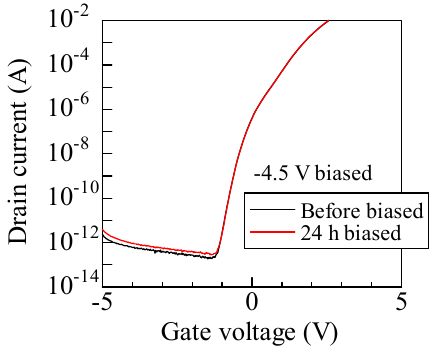
Figure 6. I D – V G curves in the subthreshold region for biased SiC MOSFETs without irradiation. For I D – V G measurement, drain voltage of 10 V were applied.